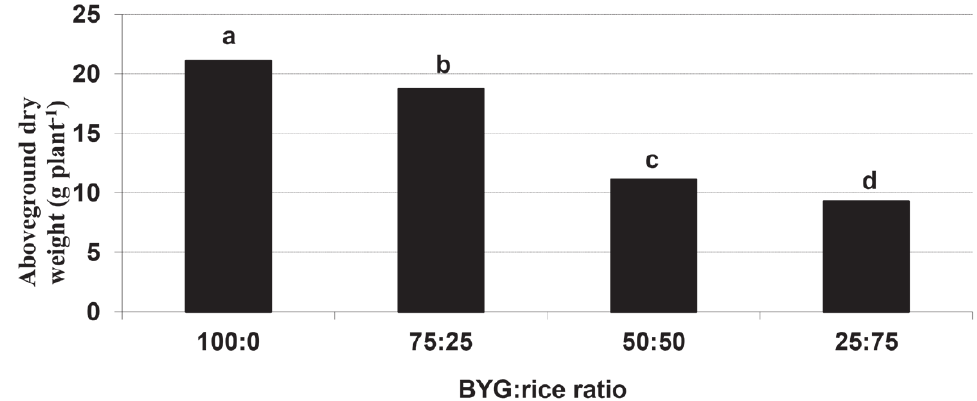
rice:BYG mixture proportion decreased from 100:0 to 25:75 (Table III). The highest (7.6 g plant -1 ) and the lowest (2.9 g plant -1 ) roots dry weight were recorded for plants grown at 25:75 and 100:0 rice:BYG mixture proportions, respectively (Table III).